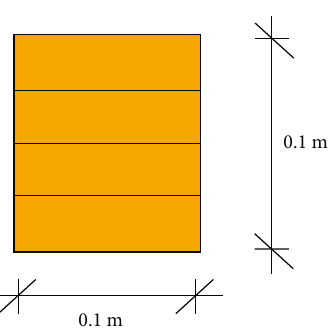
Figure 2: Exploded view TS-BRB. Figure 3: Glulam brace